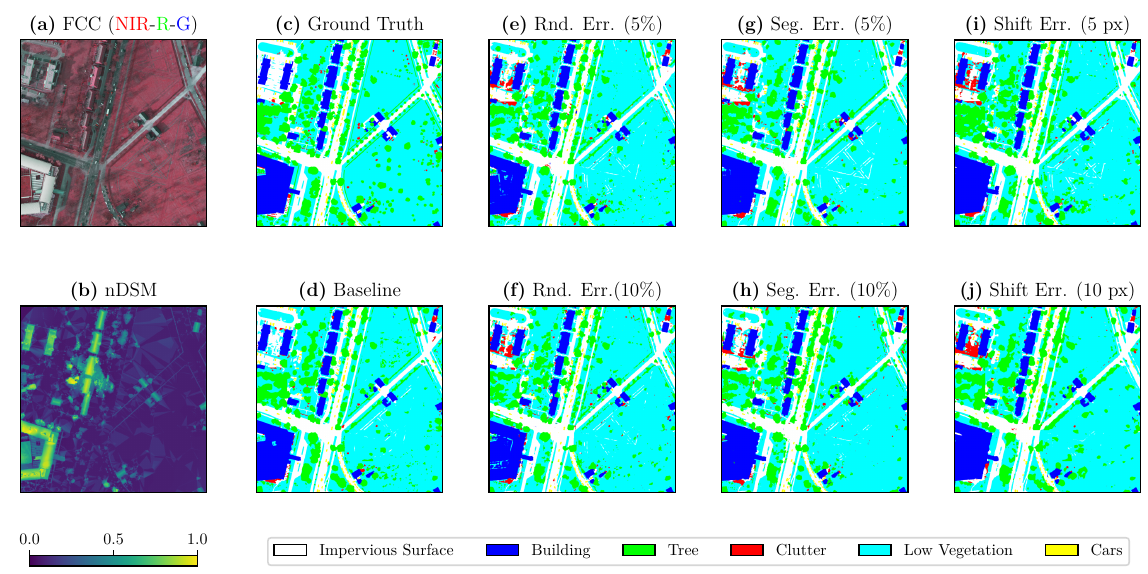
Figure 3. Illustration of predicted labels along with the overview of the scene. (a) False color composite of the scene, (b) Normalized DSM, (c) Ground Trth Label, (d) Baseline prediction, (e) - (j) predicted labels attributed to different noise type and threshold